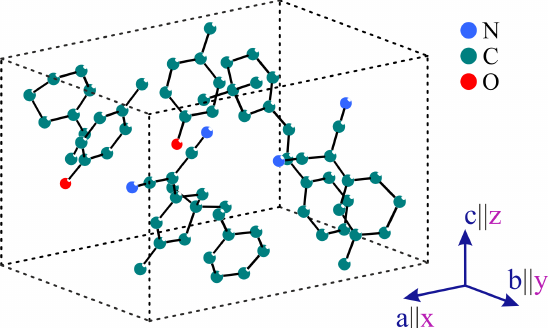
Figure 13. Crystal structure of OH1 (the .cif files taken from the CCDC database can be found in the Supplementary